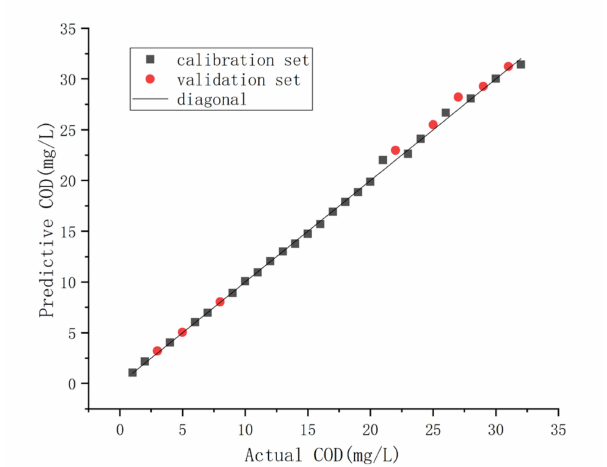
Figure 13. Fitting between predictive values and actual values in the calibration set and validation set in